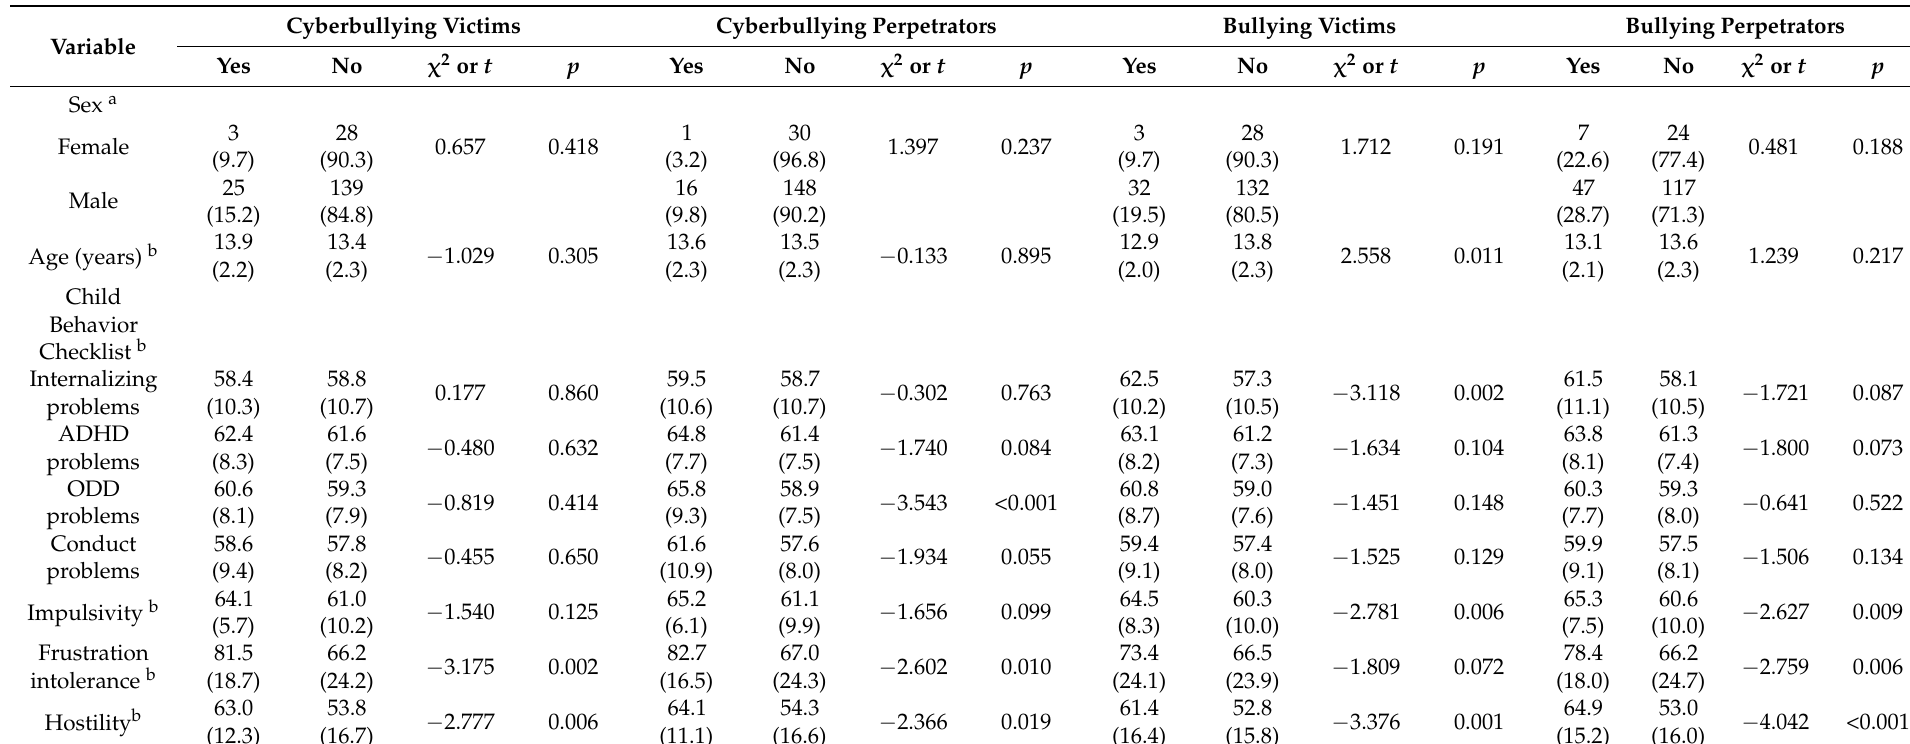
Table 3. Differences in demographic characteristics, impulsivity, frustration intolerance, hostility, and behavioral problems between victims and nonvictims and between perpetrators and